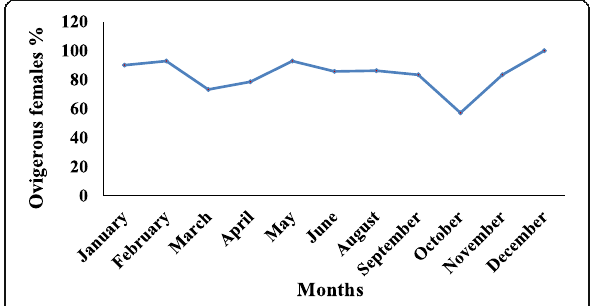
Fig. 5 Monthly percentages of H. marsupialis ovigerous females showing spawning season from Gulf of Aqaba, Red Sea, Egypt (ovigerous) and juveniles of H. marsupialis . The percent- age of mature females is 79.7%, while juveniles are 20.3% recorded in all months except January and October. The lowest value of juveniles was 1 recorded during May, September, November, and December, and the highest value was 17 recorded in June (Fig. 6). These results denote to the relatively short period for juvenile metamorphosis after hatching and to the short breeding season for this species.